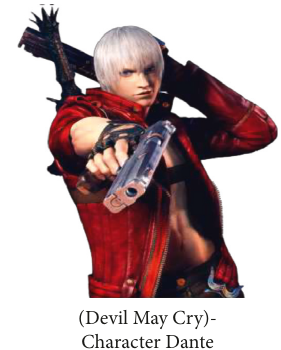
Figure 4: Virtual reality in the devil may cry series.